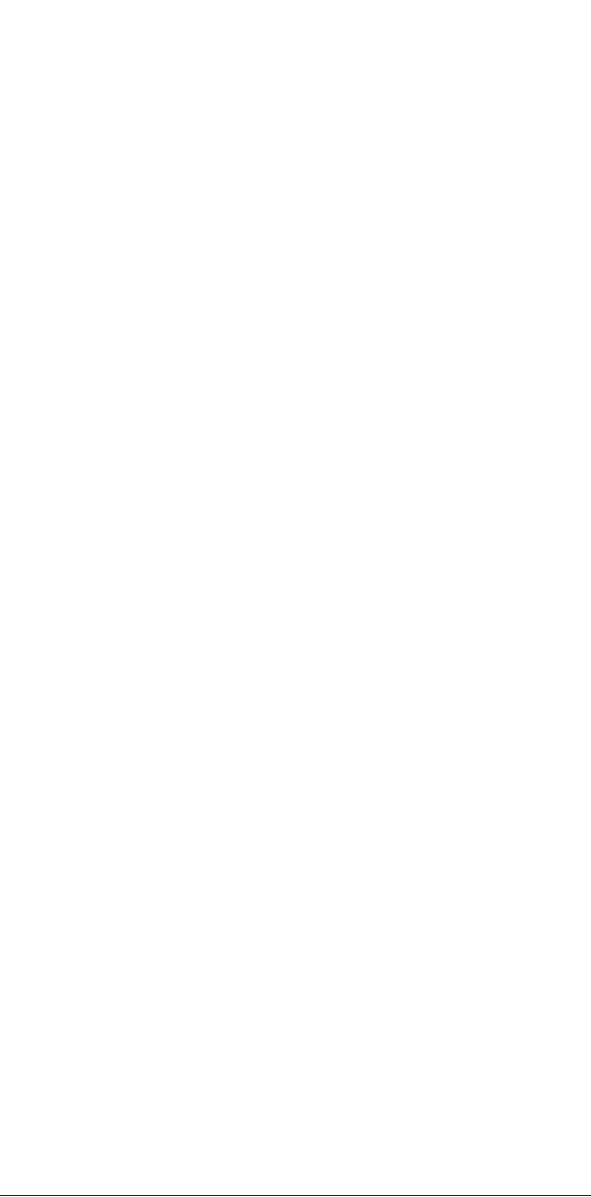
FIGURE A2 | Frequency tag dynamics in females, and in relation to another tag frequency in the surround. (A) Log-ratio for 7Hz center vs. 9Hz surround, for 40s after novelty ( n = 4 female flies,